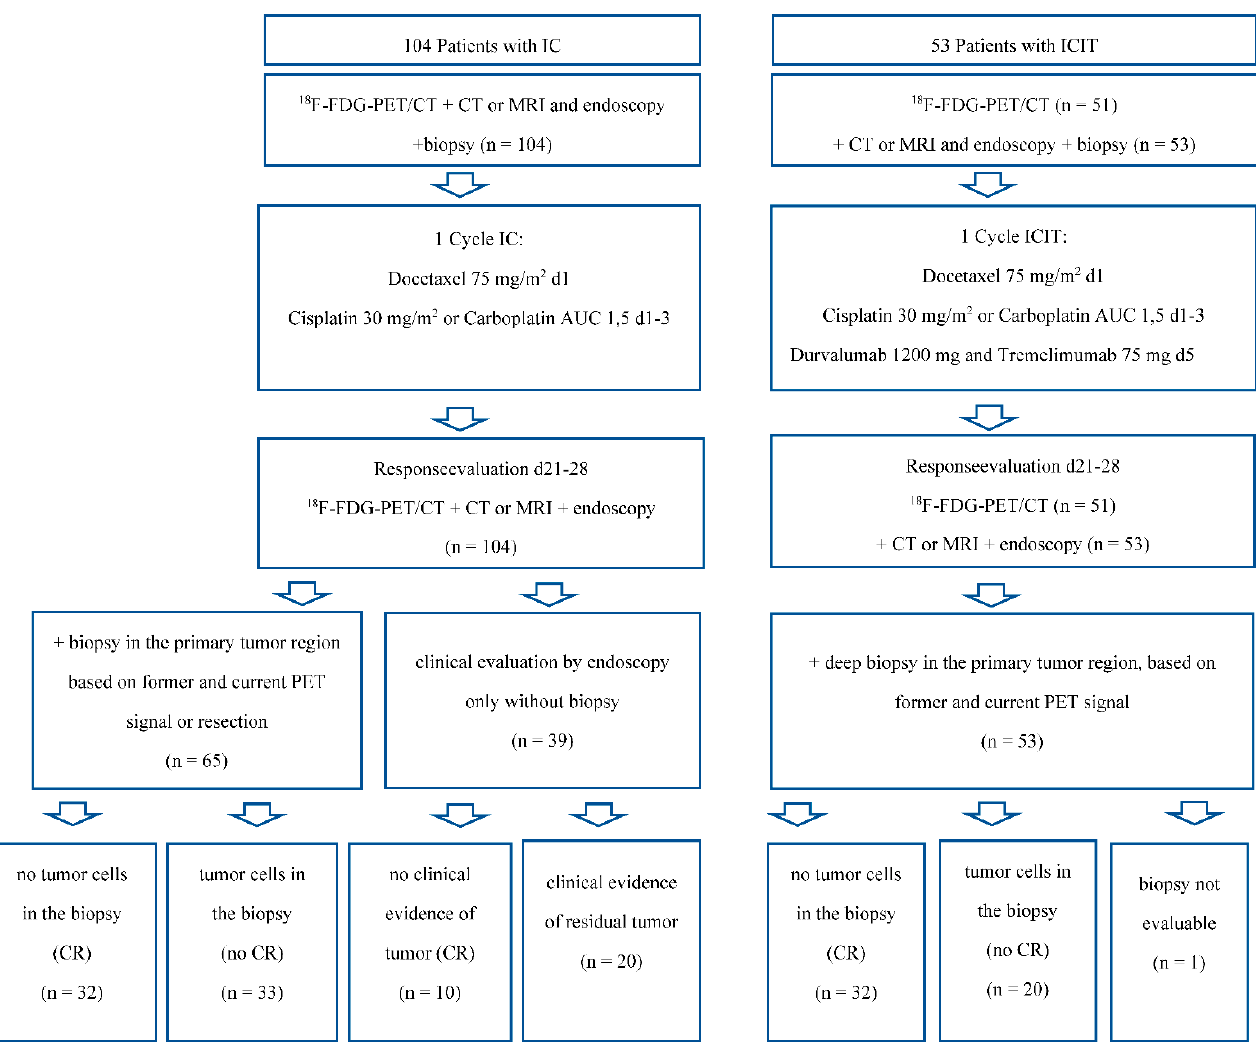
Figure 1. Patients, treatment, and response evaluation.